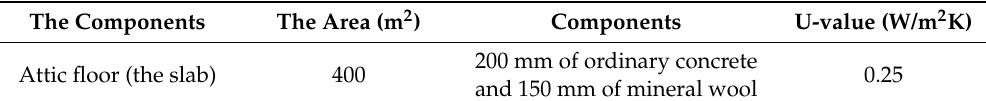
Table 5. Building envelope characteristics: attic floor.